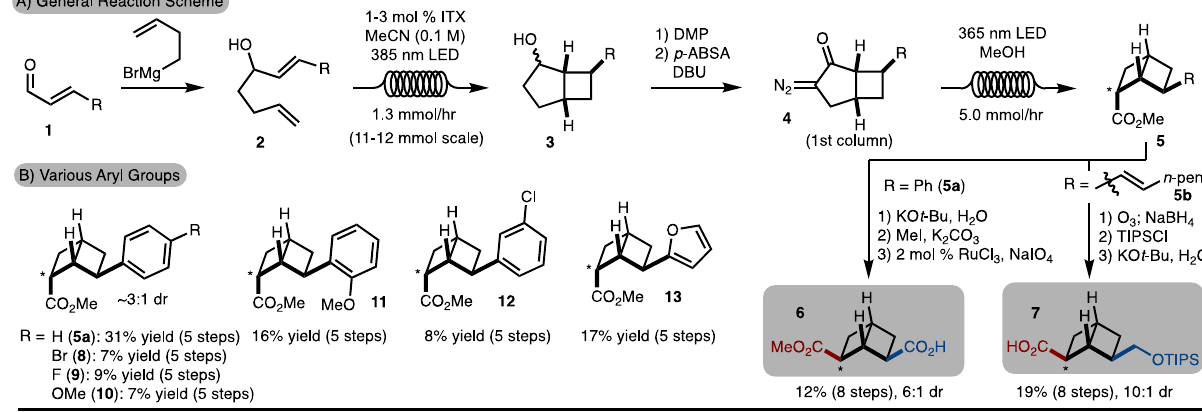
Fig. 2 | Synthetic strategy. A Synthesis of [2]-ladderane building blocks. B Other examplesthatcanbeprepared bythe outlinedroute.ITX2- i -Prthioxanthone,DMP